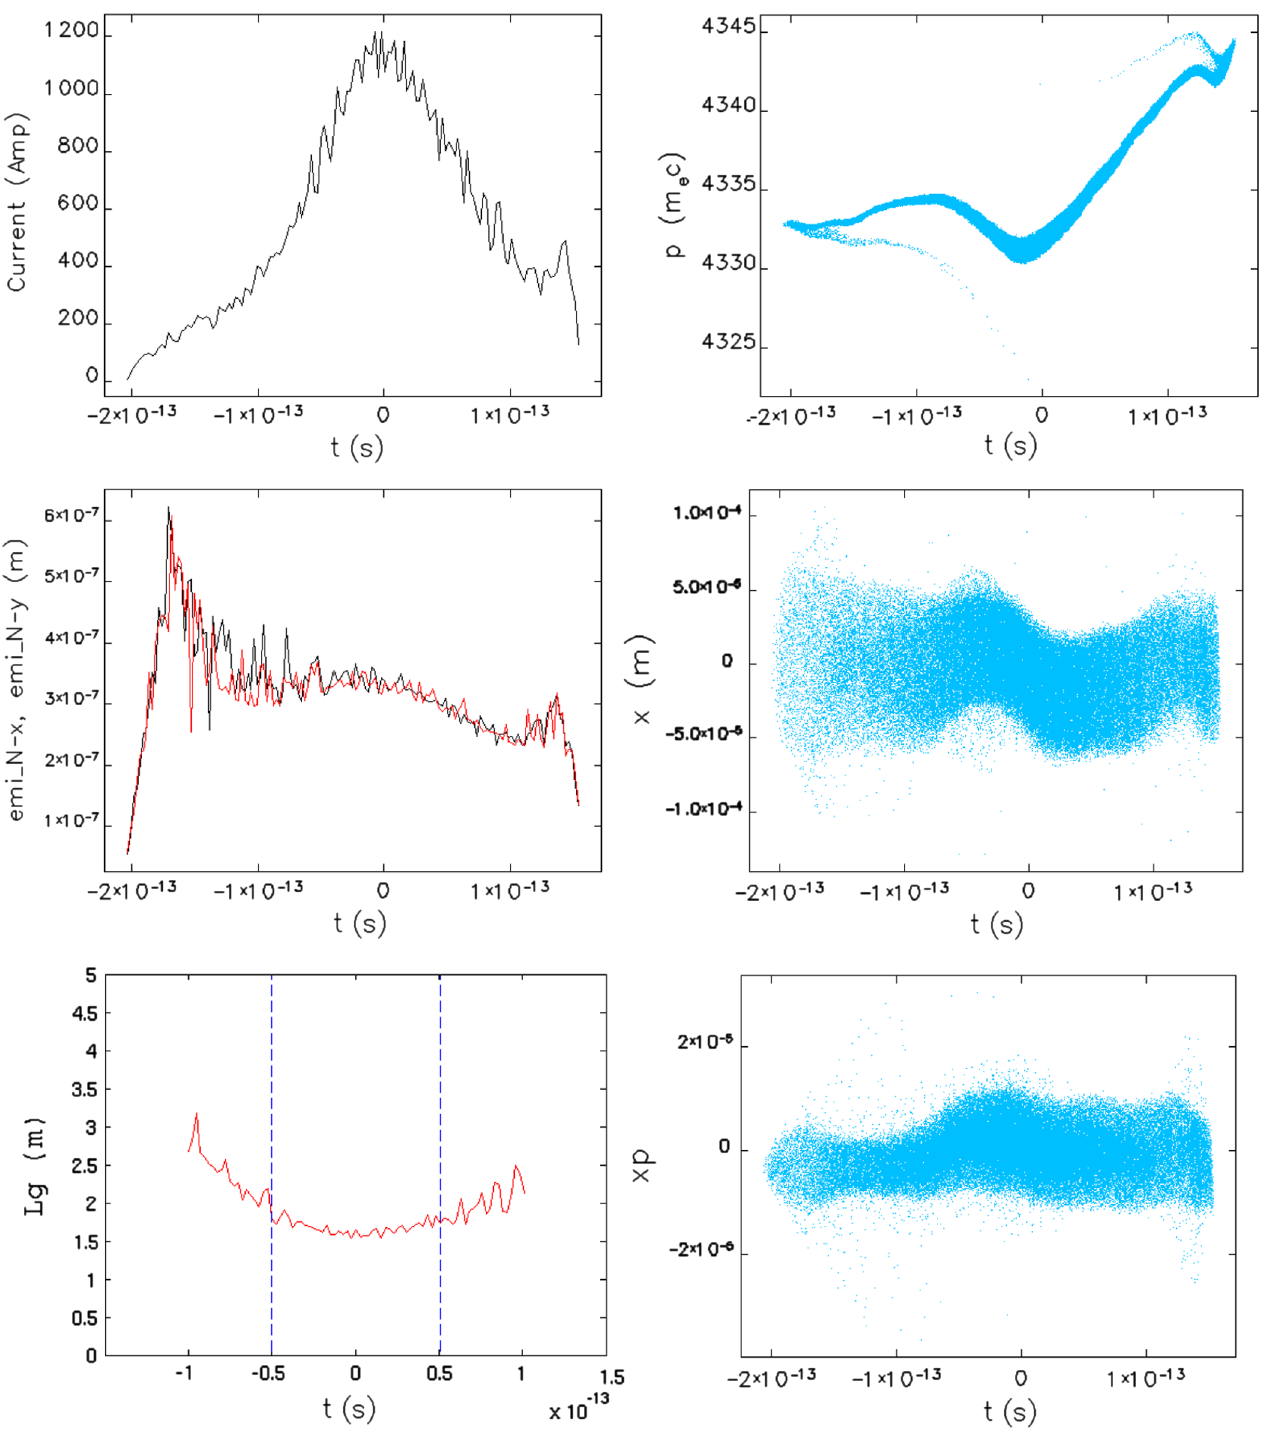
FIG. 4. Phase space and slice analysis for the electron bunch on the Pareto-optimal front selected from Fig. 3 and corresponding to the red dot. Current distribution (top left), normalized emittance distribution (middle left), gain length per slice (bottom left), ; t Þ phase space (bottom longitudinal phase space (top right), ð x; t Þ phase space (middle right), and ð x p remaining two compressors are of S-type. The parameters used in the MOGA were the strength of the three bunch compressors, the voltage and phase of the two accelerating Fig. 2. The first compressor is a C-type chicane while the sections before the second bunch compressor, and the